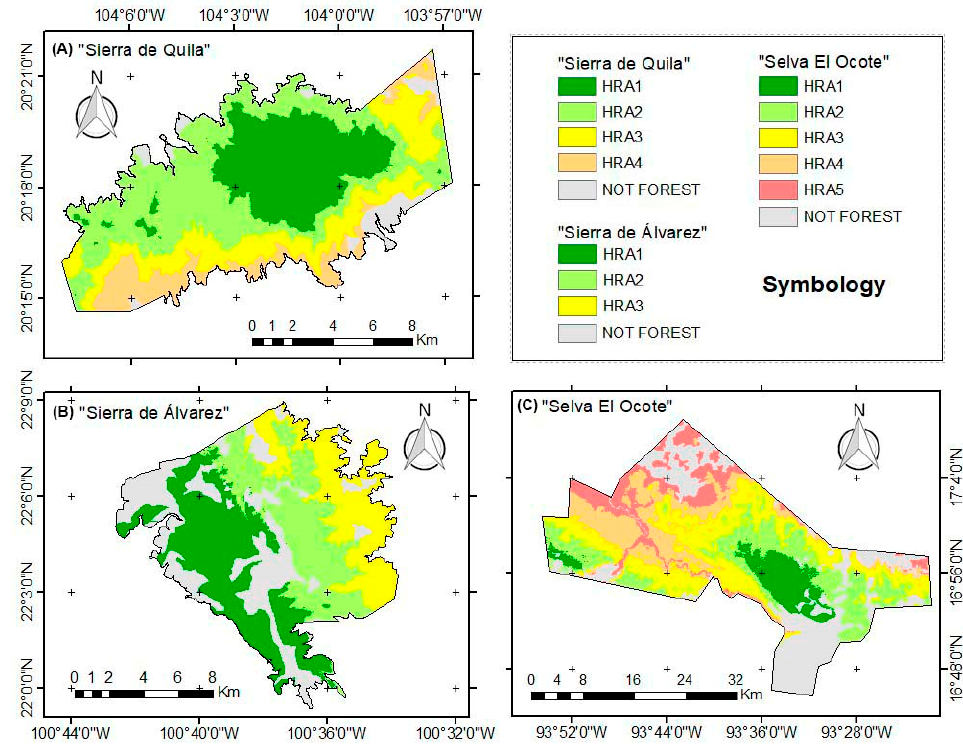
Figure 4. HRAs spatial distribution; ( A ) “Sierra de Quila”; ( B ) “Sierra de Álvarez” and ( C ) “Selva El Ocote”. Table 1. Confusion matrix of the validation dataset in “Sierra de Quila.” Prod.Accu = Producer Accuracy and User.Accu = User Accuracy.